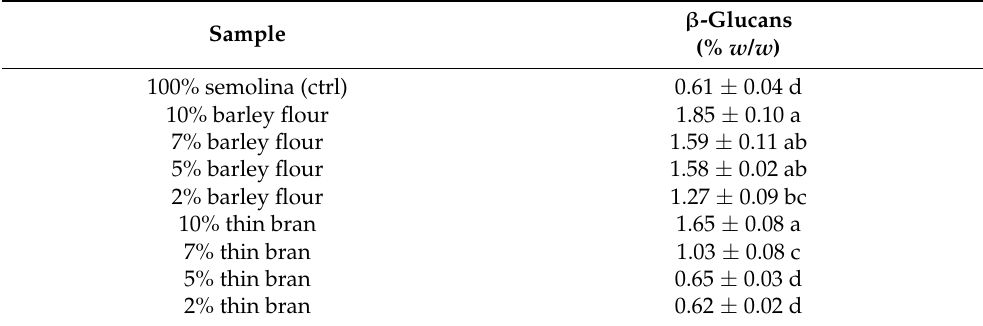
Table 10. β -glucans content of the semolina bread with different bread sample formulations (data are means ± standard deviations).